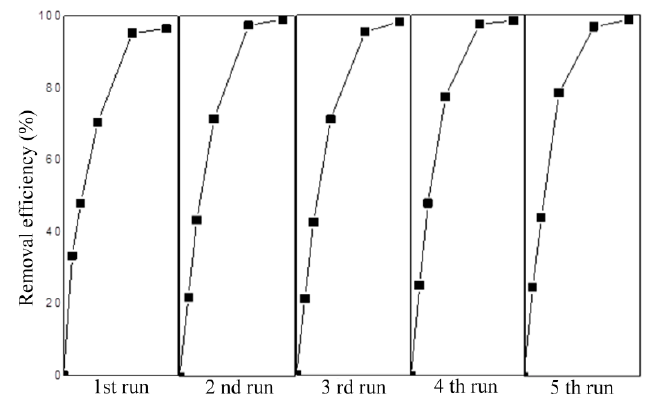
Figure 10. Kinetic curves for the reuse of 29 tablets of Fe 2 O 3 /TiO 2 /PVC composites in the case of MB ( c 0 = 2.45 · 10 − 2 mM) removal under SSR, at a stirring rate of 490 rpm.